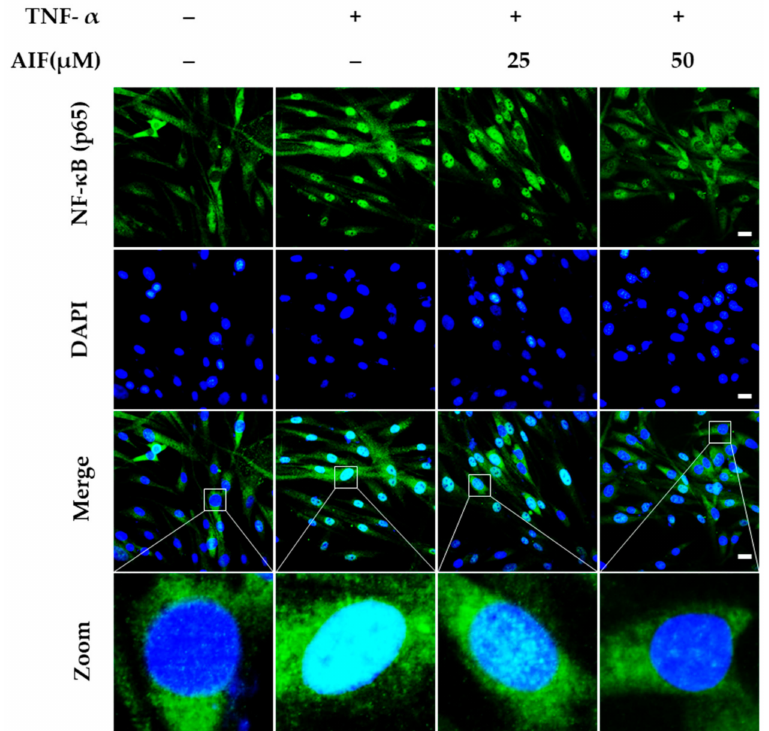
Figure 8. Inhibitory effect of nuclear factor- κ B (NF- κ B) (p65) translocation by alpinumisoflavone (AIF) in tumor necrosis factor- α (TNF- α )-treated human dermal fibroblasts (HDFs). AIF in TNF- α -treated HDFs. HDFs were challenged with 20 ng/mL TNF- α in the presence or absence of AIF (25 and 50 µ M) for 3 min. The expression of NF- κ B (p65) was visualized using immunofluorescence staining (40 × magnification, scale bar: 20 µ